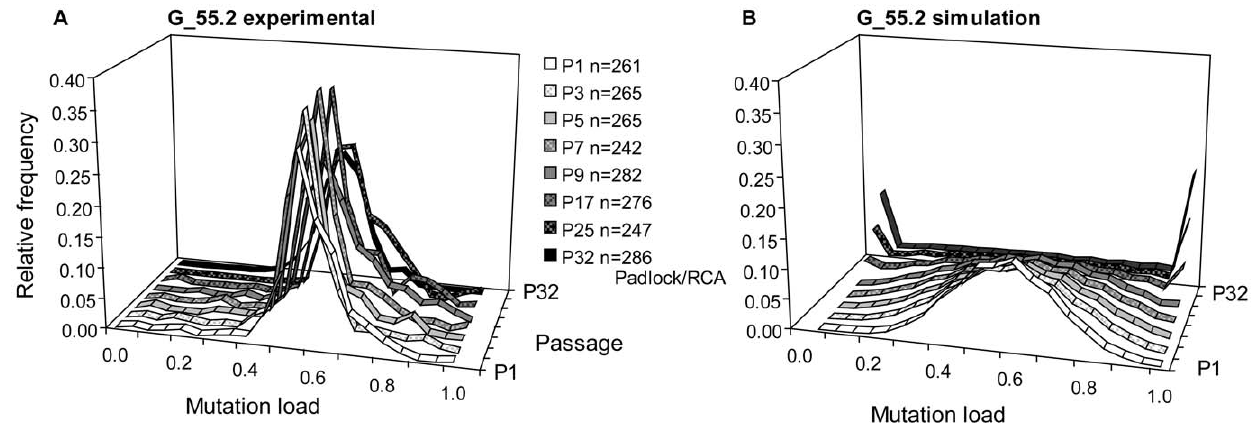
Figure 8. Cellular heteroplasmy evolution of clone G_55.2. (A) Relative m.3243A . G mutation load frequency histograms of cells in multiple passages of G_55.2. With exception of P32, histograms were produced by PCR/RFMT of flow-sorted single cells. Mutation loads of cells in P32 were measured by Padlock/RCA using cells $ 40 dots/cell, which represented 80% of the analyzed cells. SDs for the single cell PCR/RFMT mutation load determinations of P1–P25 ranged from 4 to 8%. (B) Relative mutation load frequency histograms of cells in passages P1–P32 of clone G_55.2 generated by computer simulation of random segregation.